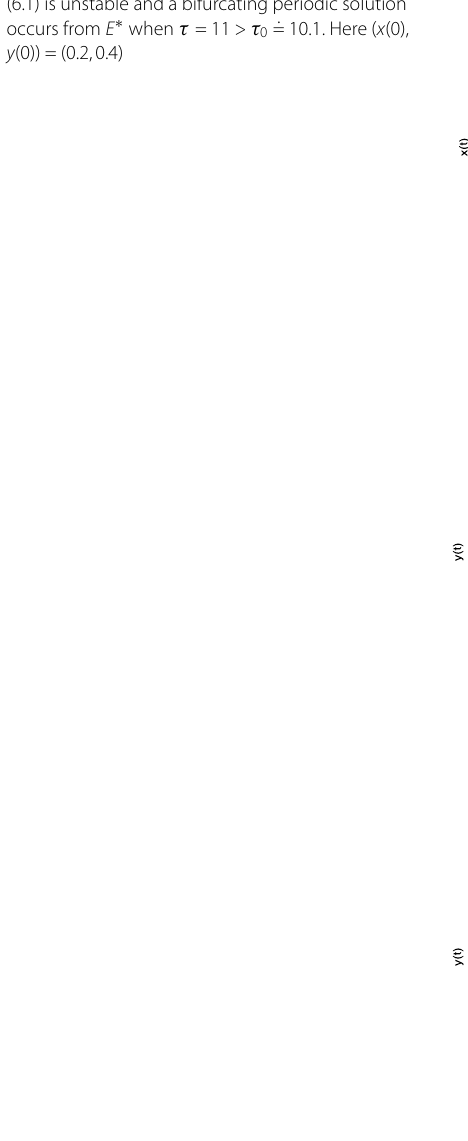
Figure 2 The positive equilibrium E ∗ = (0.5,0.27) of (6.1) is unstable and a bifurcating periodic solution occurs from E ∗ when τ = 11 > τ 0 y (0)) =